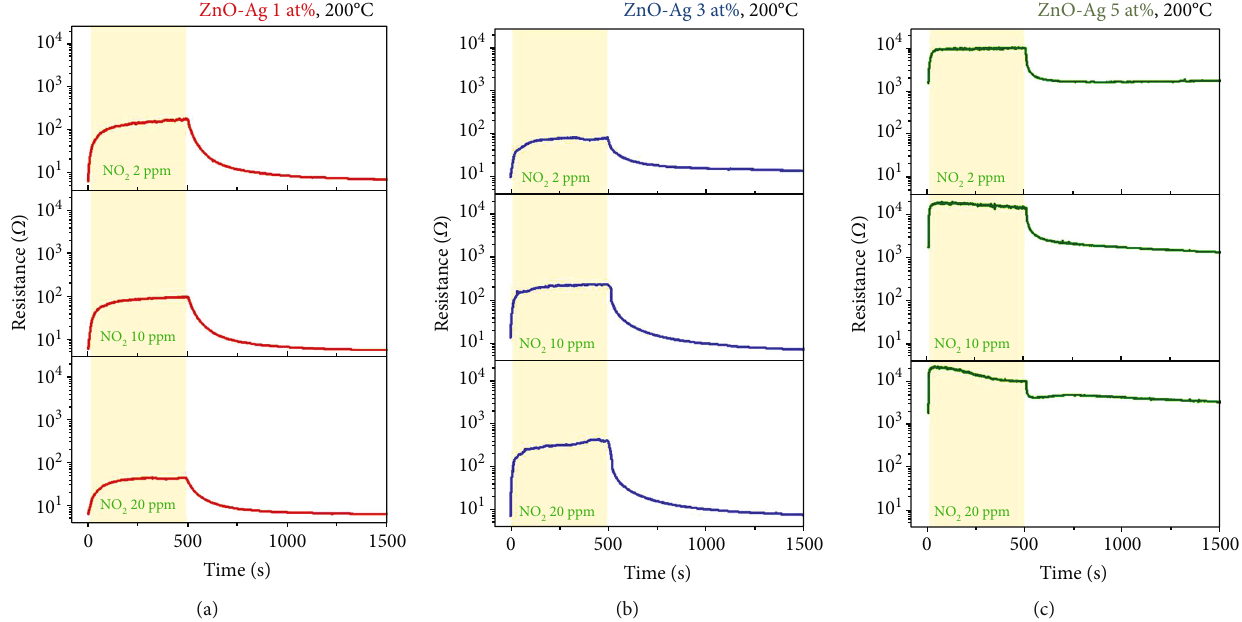
Figure 6: Dynamic resistance curves of the (a) 1, (b) 3, and (c) 5 at% Ag-functionalized porous ZnO sheet gas sensor at 200 ° C to 2, 10, and 20ppm NO 2